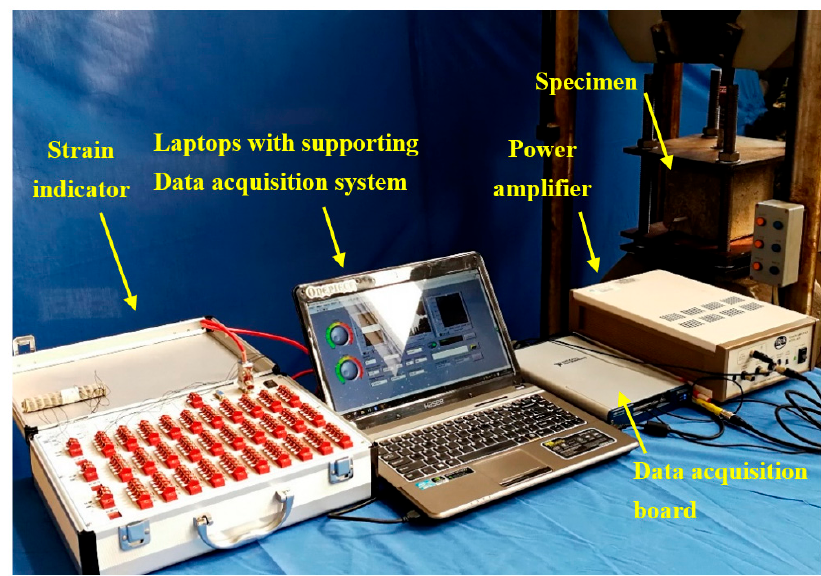
Figure 6. Instrument Setup.